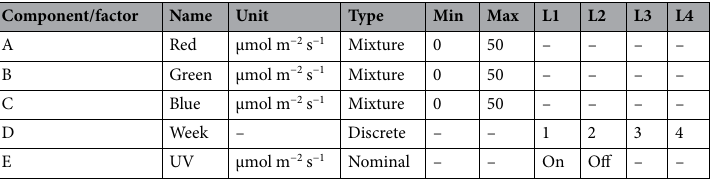
Table 2. Overview of mixture components, factors and factor levels used in the response surface model. To plan the DoE-setup we used a mixture design with the intensity of red, green and blue light as the three components of the mixture (component A-C). The sum of all three components had to be 50 µmol m −2 s −1 leading to a minimum intensity (Min.) of 0 µmol m −2 s −1 and a maximum (Max.) of 50 µmol m −2 s −1 for each component itself. We included the cultivation week as a discrete factor (factor D) with four levels (L1 = Level 1, L2 = Level 2, L3 = Level 3, L4 = Level 4) where each level represents one week of cultivation. The intensity of UV light (factor E) was included as a nominal factor with two levels (L1 = Level 1, L2 = Level 2), where L1 means UV light was turned on and L2 means that UV light was turned off. These components and factors with their levels were used to generate the DoE-runs shown in Table